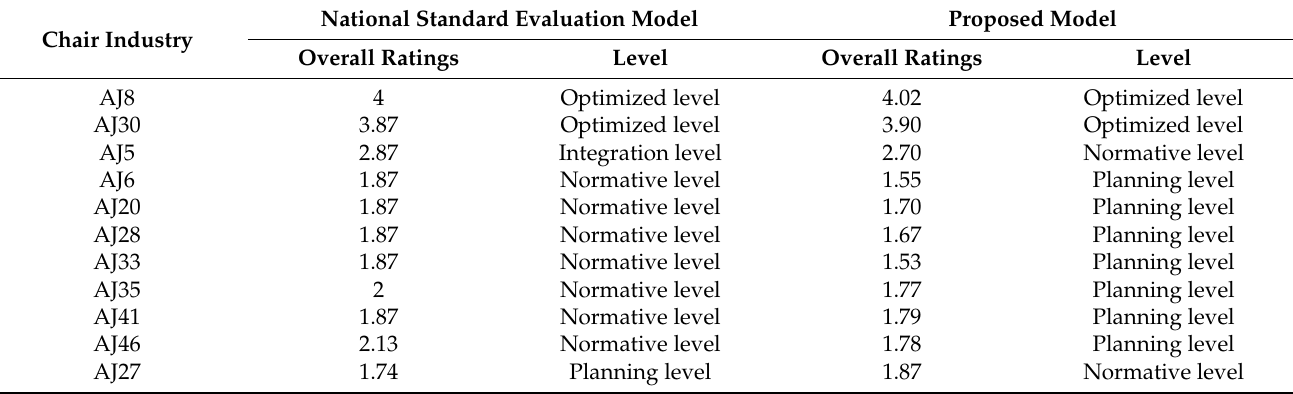
Table 4. Comparative analysis of evaluation results of different models (part of enterprises).